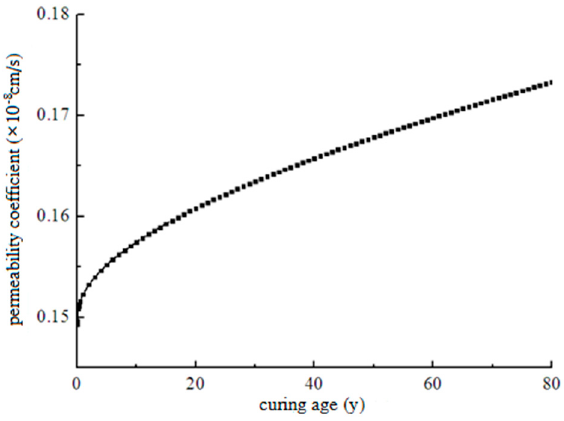
Figure 17. The time-history curve of the equivalent permeability coefficient of the diaphragm wall.